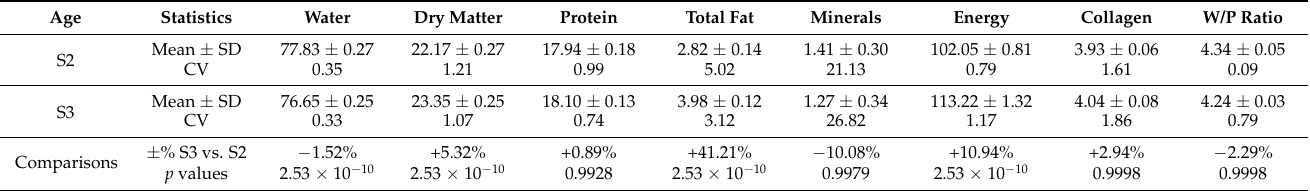
Table 3. Chemical composition and certain nutritional features of Polyodon spathula fillet, aged